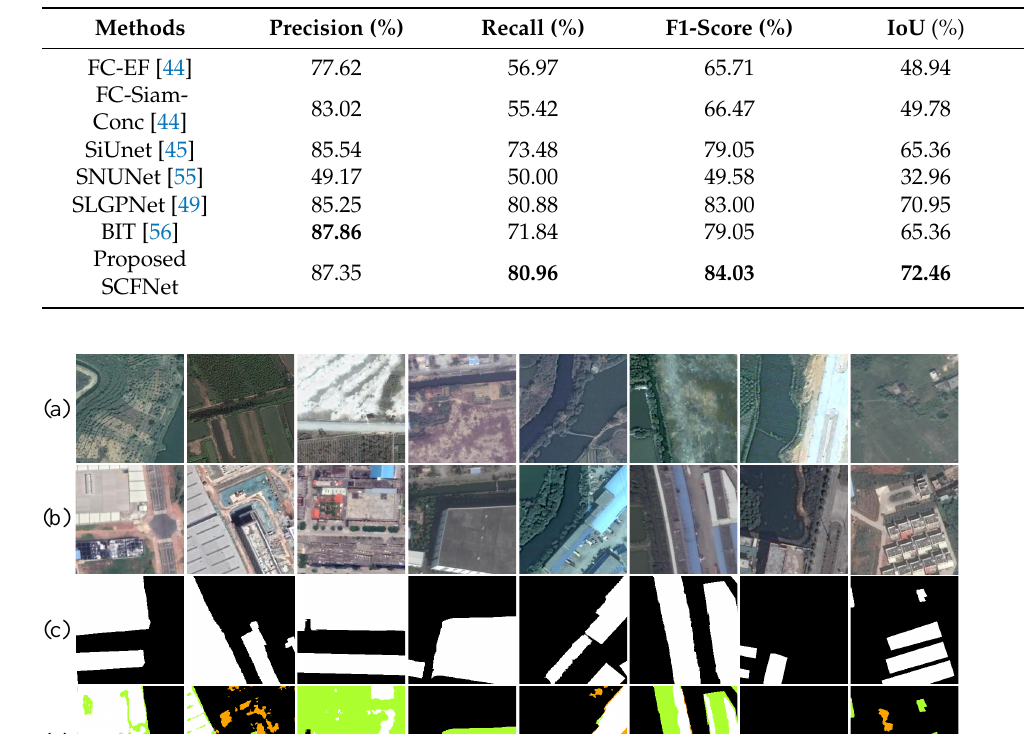
Table 2. Quantitative comparison of different methods on the Guangzhou data set.